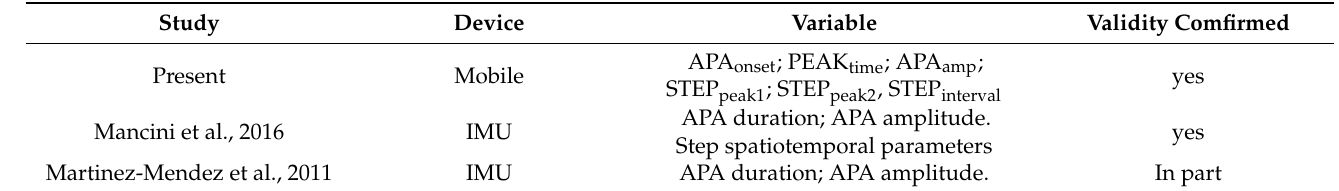
Table 2. Summary of literature using Accelerometers for APAs assessments during gait initiation. Study Device Variable Validity Comfirmed